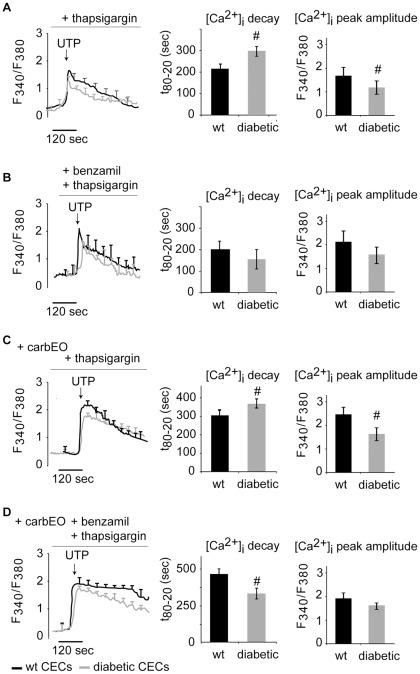
Diabetes alters Ca2+ NCX activity without affecting PMCA-mediated efflux.(A): CECs were treated with SERCA inhibitor (thapsigargin) to study the effect of diabetes on intracellular Ca2+ efflux mechanism without contributions from Ca2+ sequestration mechanism. UTP-evoked [Ca2+]i decay time was significantly increased and the peak amplitude was decreased in diabetic CECs, as compared to wild-type controls. (B): CECs were treated with SERCA (thapsigargin) and NCX (benzamil) inhibitors to study the effect of diabetes on PMCA-mediated Ca2+ efflux. Under these conditions, there was no significant difference in UTP-evoked [Ca2+]i transients between diabetic and wild-type CECs. (C): CECs were treated with SERCA (thapsigargin) and PMCA (carbEO) inhibitors to study the effect of diabetes on NCX-mediated Ca2+ efflux. In diabetic CECs, NCX activity was significantly reduced as indicated by increased decay time of UTP-evoked [Ca2+]i transients. The peak amplitude was also significantly reduced in diabetic CECs under these conditions. (D): To confirm effect of diabetes on [Ca2+]i transients, Ca2+ decay was inhibited by treating CECs with SERCA (thapsigargin), PMCA (carbEO) and NCX (benzamil) inhibitors. In wild-type CECs, [Ca2+]i decay was completely blocked, while diabetic CECs still showed Ca2+ removal from the cytosol, with [Ca2+]i decay time significantly faster than that in wild-type CECs. No change in peak amplitude was observed under these conditions (#: p<0.05; cell no. A: 69 (wt), 93 (db); B: 83 (wt), 73(db); C: 74 (wt), 71 (db); D 76 (wt), 72 (db)).